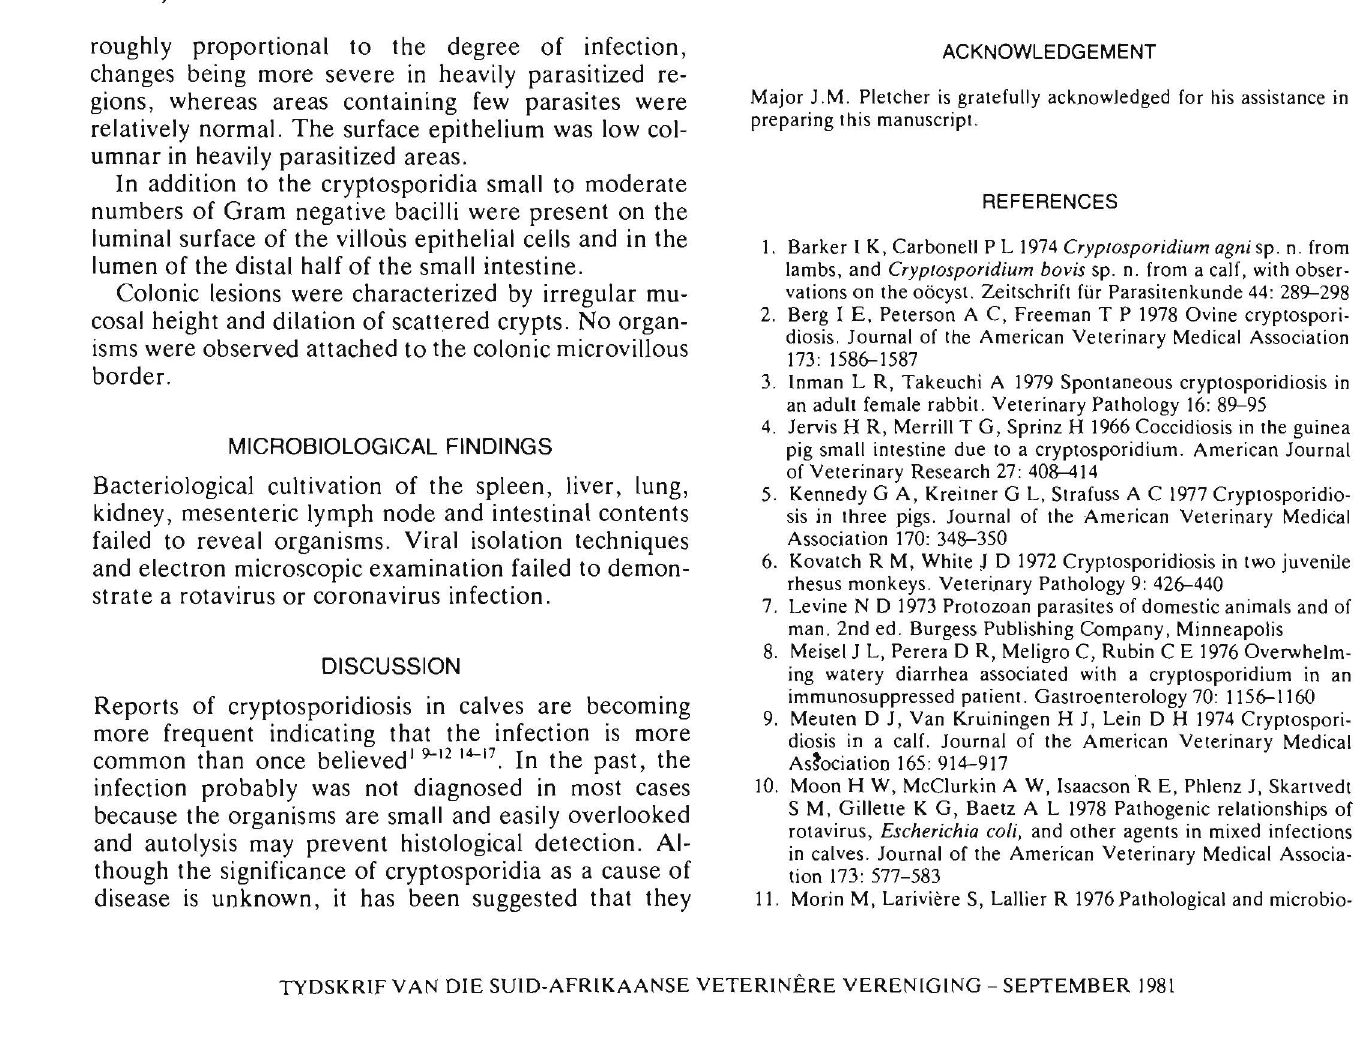
Fig. 2 Enlargement of Fig. 1. Note the various sizes and shapes of cryptosporidia (arrow) representing different stages in the life cycle. HE x